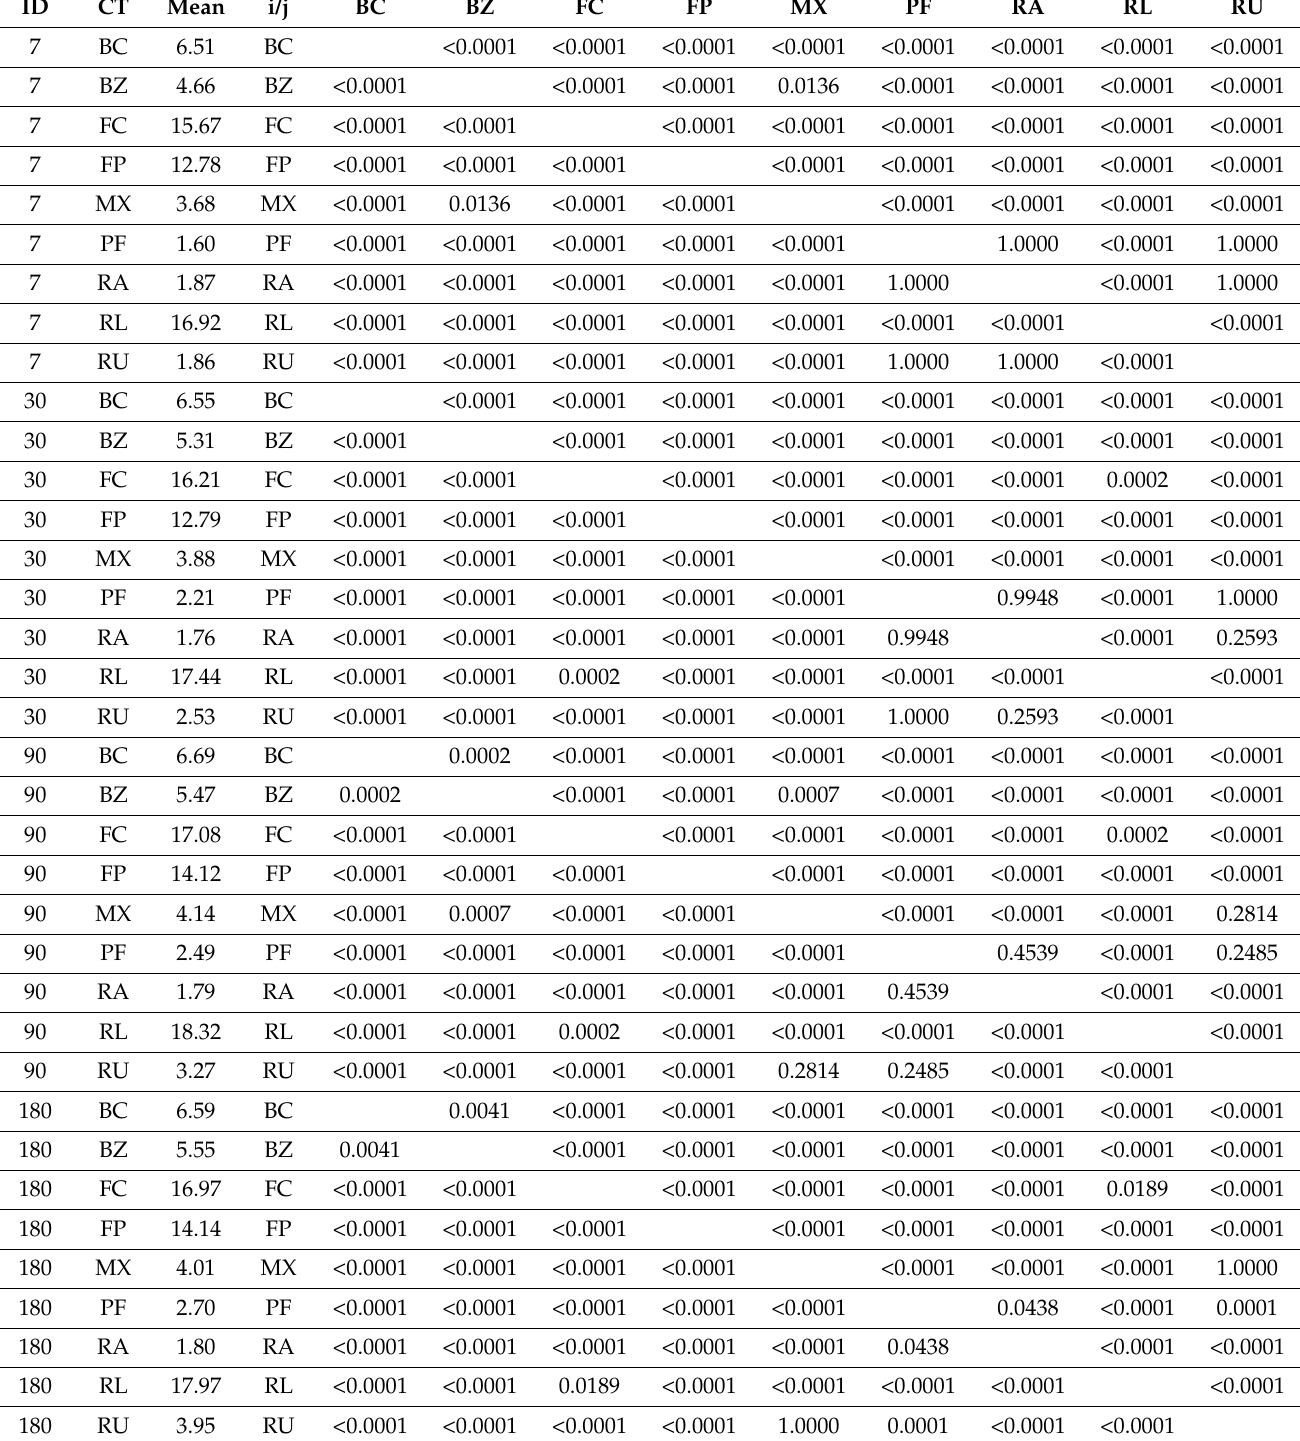
Table 5. Statistical comparison of WSP (%) among different cement types in a specific immersion duration subgroup. (Pair-wise comparisons within immersion duration; Tukey adjusted p